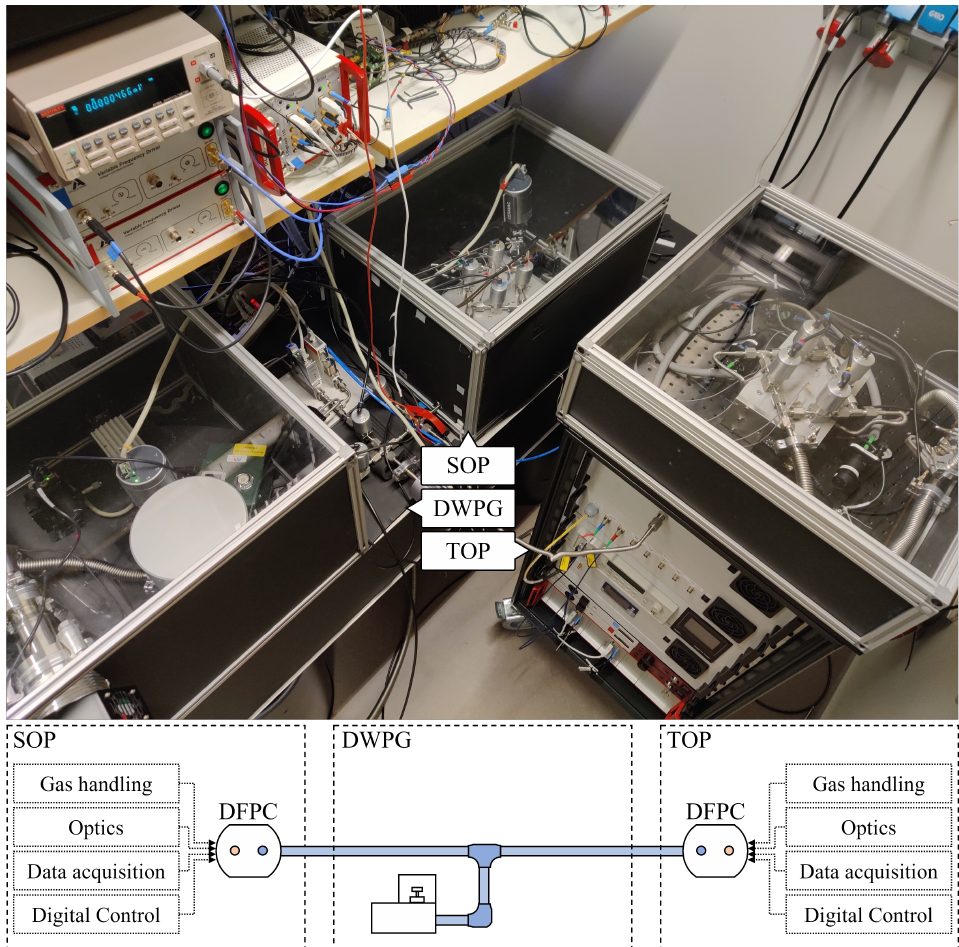
Figure 1. The dual refractometry system scrutinized in this work. It consists of three main com- ponents: the SOP (the system in the rightmost box on the optical table); the TOP-refractometer (the standalone system to the right); and the DWPG (the system in the leftmost box on the optical table). In addition to this, it comprises a common gas supply (seen between the SOP and DWPG boxes), a common vacuum system (not in the figure), a computer (for control and data acquisition), and various electronics—for the SOP, partly seen on the shelves, and for the TOP, in the rack. In the bottom part of the figure, a schematic showing the subsystems of the two refractometers and their connection to the DWPG is presented. The blue gas line represents the gas pressure under assessment and the red circles within the DFPCs represent evacuated